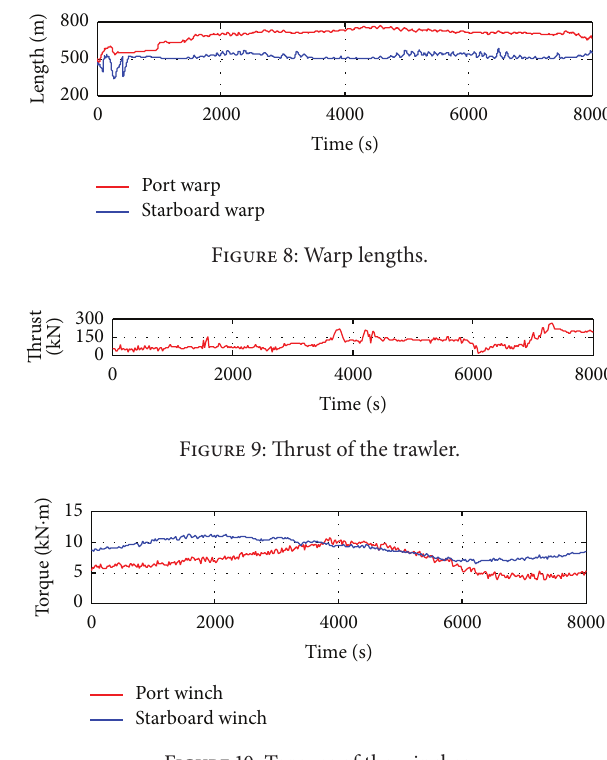
Figure 10: Torques of the